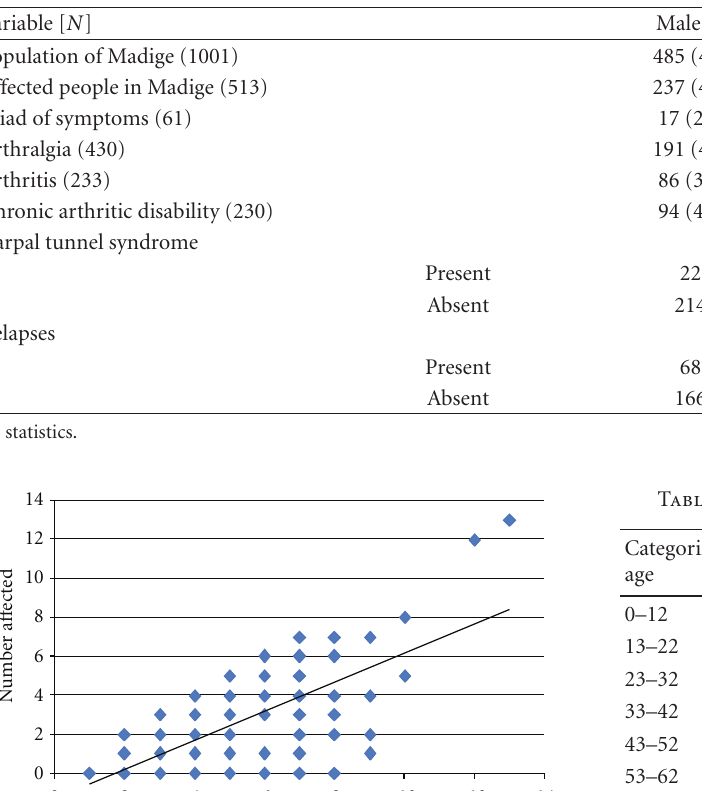
Table 1: Gender-based analysis of features.